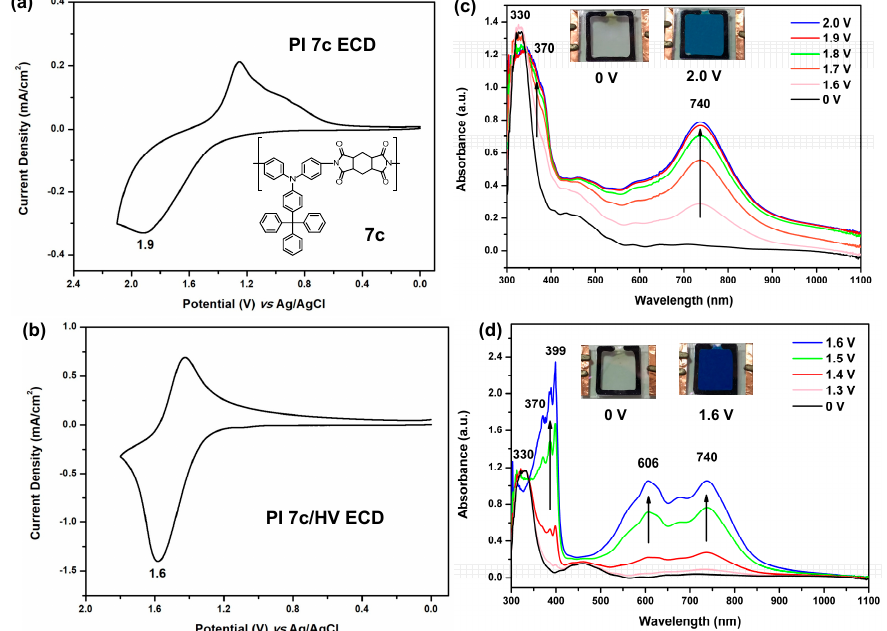
Figure 12. ( a ) CV diagram of the ECD (ITO/PI 7c film/gel electrolyte/ITO) based on the cast film (thickness: 250 ± 30 nm) of PI 7c on the ITO-coated glass substrate; ( b ) CV diagram of the ECD based on PI 7c /HV; ( c ) Spectra and color change of the ECD based on PI 7c at indicated applied voltages; ( d ) Spectra and color change of the PI 7c /HV ECD at indicated applied voltages. The semi-gelled electrolyte consists of 10-wt % PMMA (average M w = 120,000) in 0.6 M LiBF 4 /propylene carbonate.